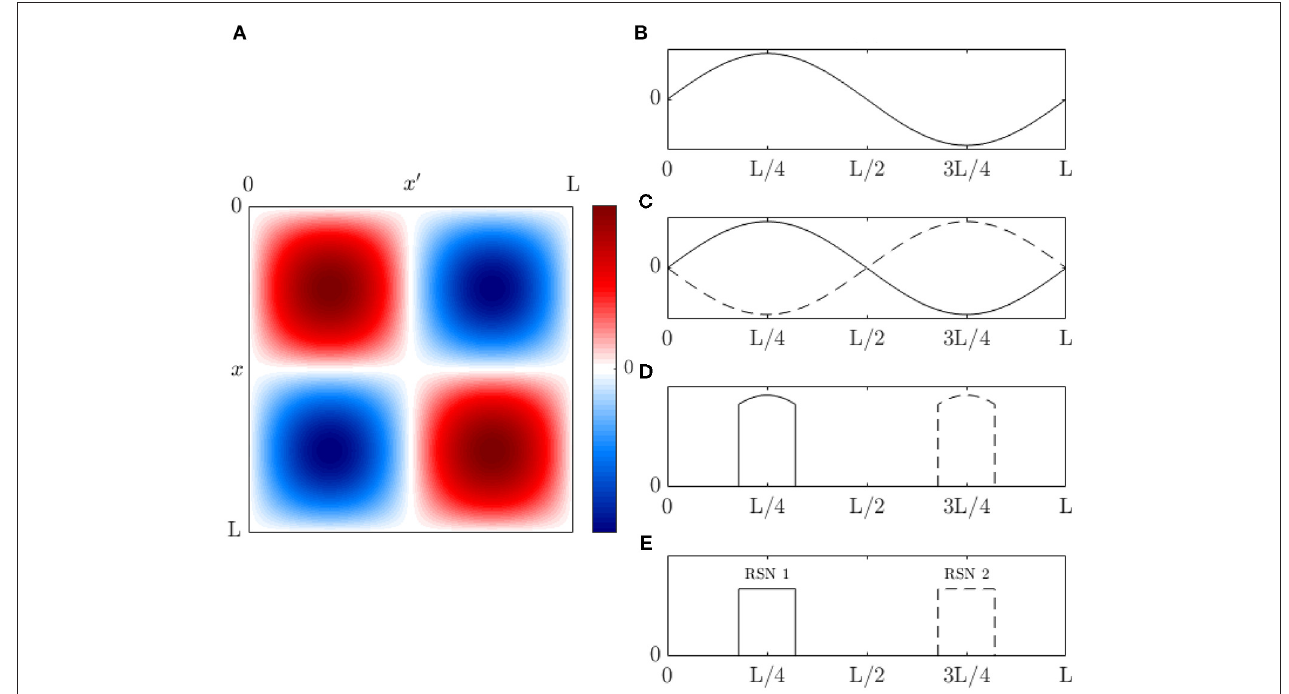
FIGURE 13 | Schematic RSNs of a violin string with periodic boundary conditions. (A) Correlations between points at x and x ′ for the mode shown in (B) , with positive values shown red and negative blue. (B) One sinusoidal mode. (C) Correlations with the points L / 4 (solid) and 3 L / 4 (dashed). (D) Thresholded correlations for the two cases in (C) . (E) RSNs defined by large positive correlations between